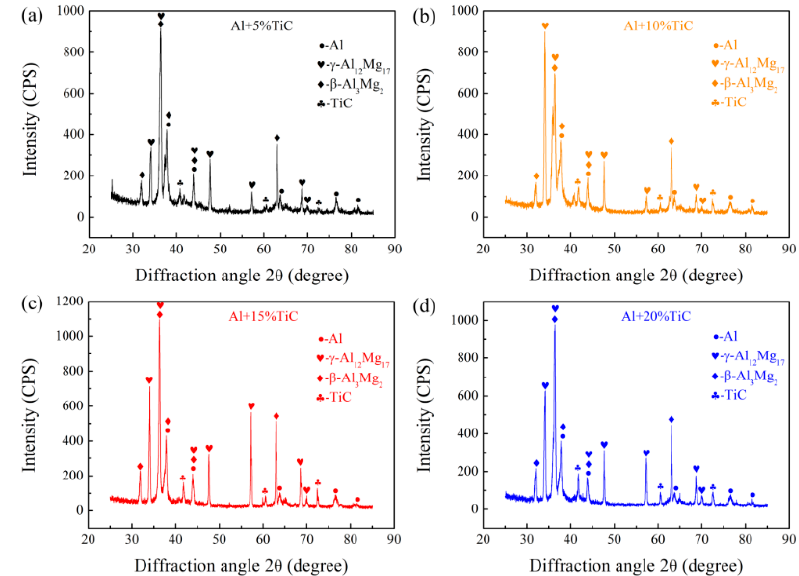
Figure 4. XRD analysis of composite coatings: ( a ) Al+5wt%TiC; ( b ) Al+10wt%TiC; ( c ) Al+15wt%TiC; ( d ) Al+20wt%TiC.